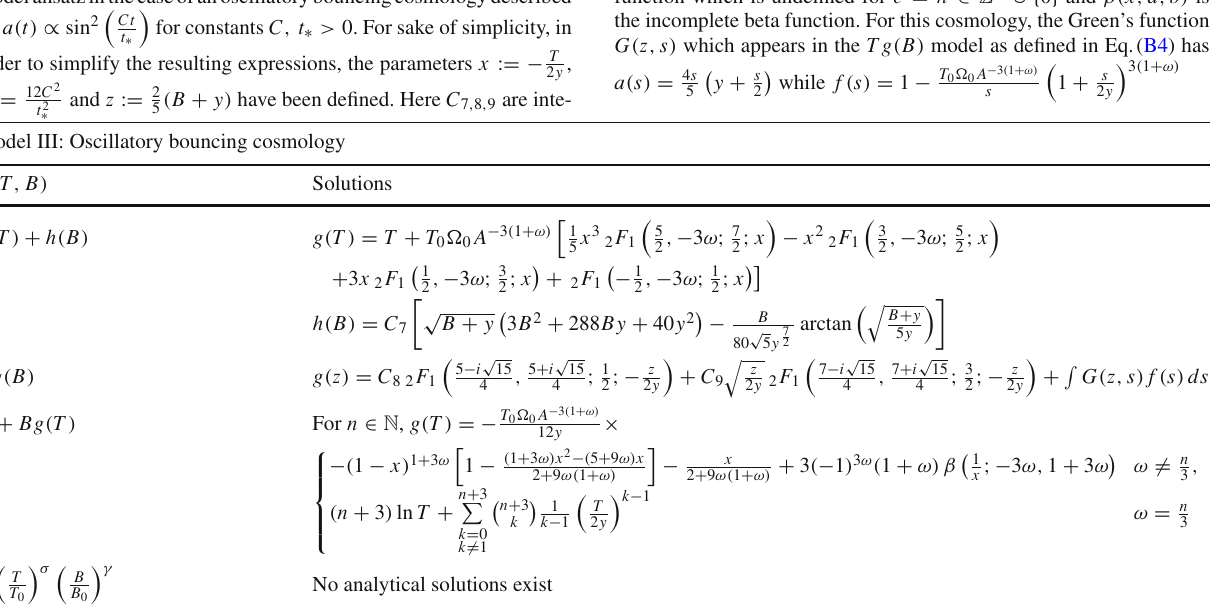
Table 5 A summary of the Lagrangian solutions for the considered modelansatzinthecaseofanoscillatorybouncingcosmologydescribed by a ( t ) ∝ sin